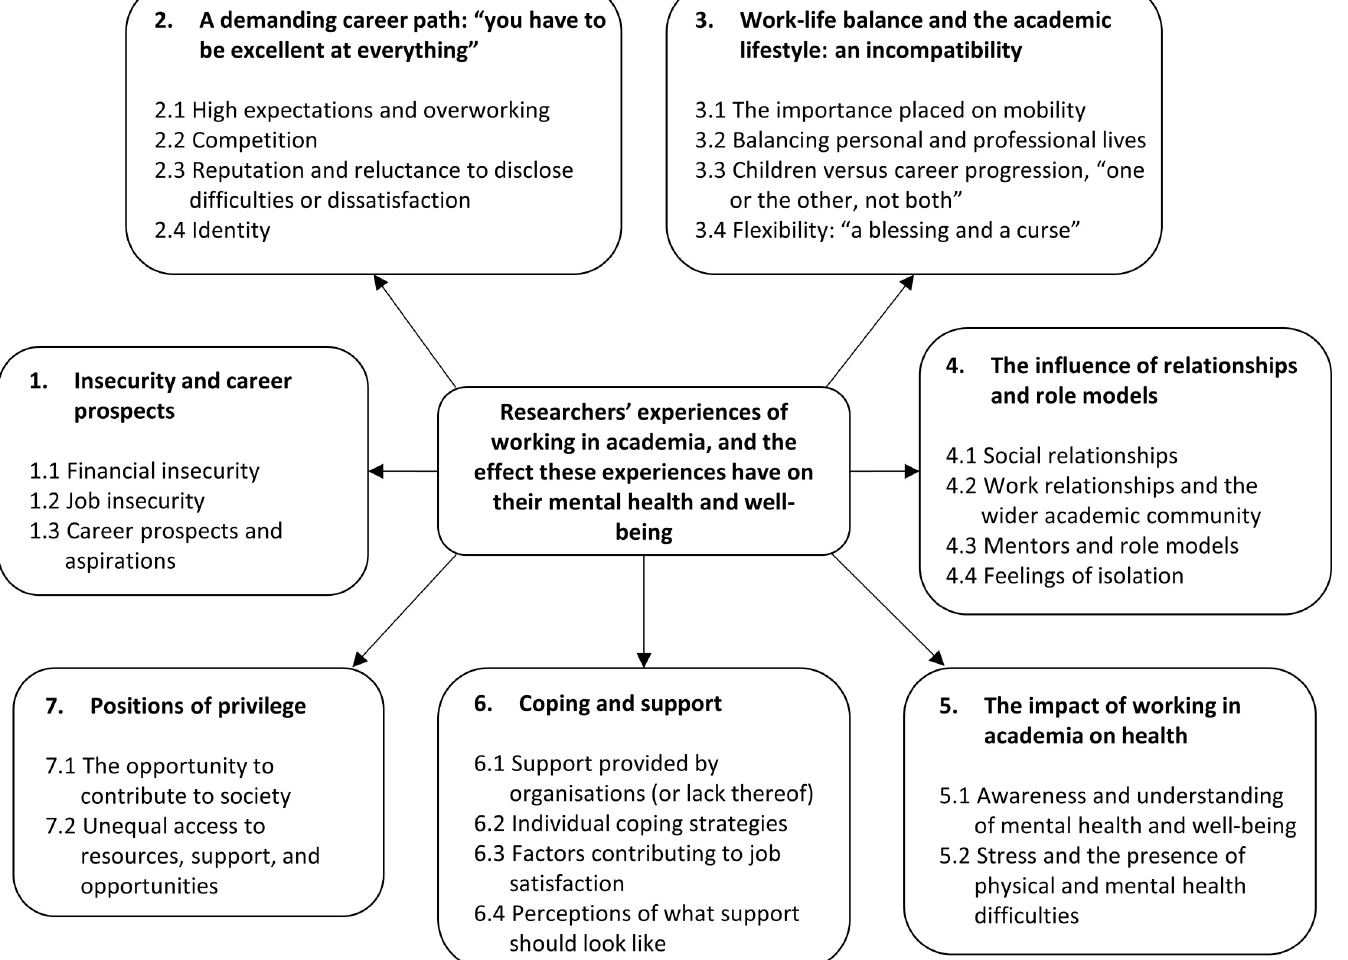
PLOS ONE | https://doi.org/10.1371/journal.pone.0268890 May 25,